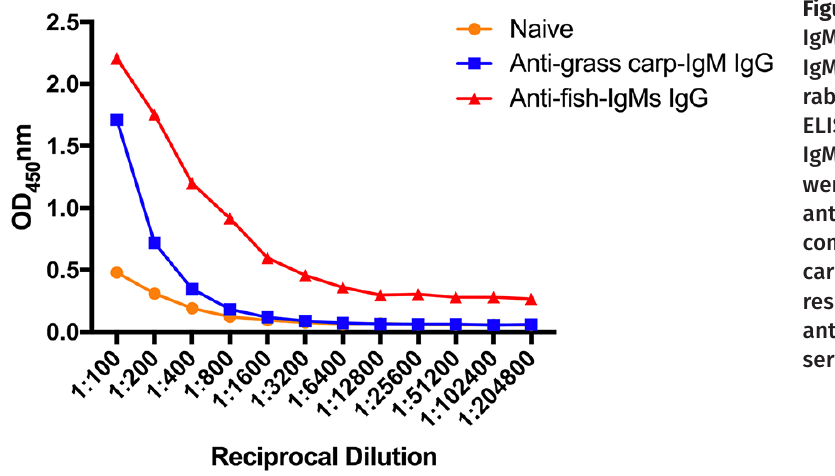
Figure 5. Detection of Specific IgM using rabbit IgG anti-fish IgMs we generated or commercial rabbit IgG anti-grass carp IgM by ELISA. Antibody titers of specific IgM induced by B.s -CotC- Cs TCHP were detected by using rabbit IgG anti-fish IgMs we generated or commercial rabbit IgG anti-grass carp IgM as second antibody, respectively. Naive indicated antibody titers of specific IgM in serum from preimmunized